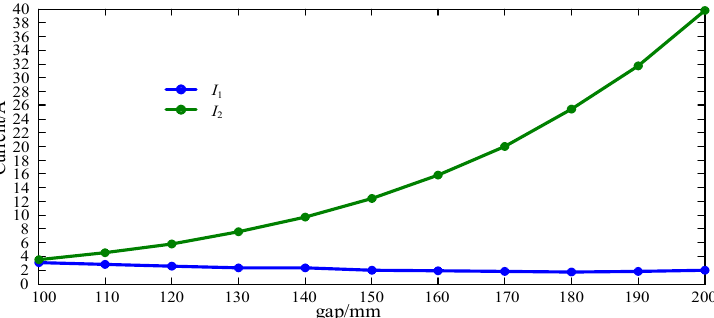
Figure 11. Current Versus Transfer Distance for 2-coil System.